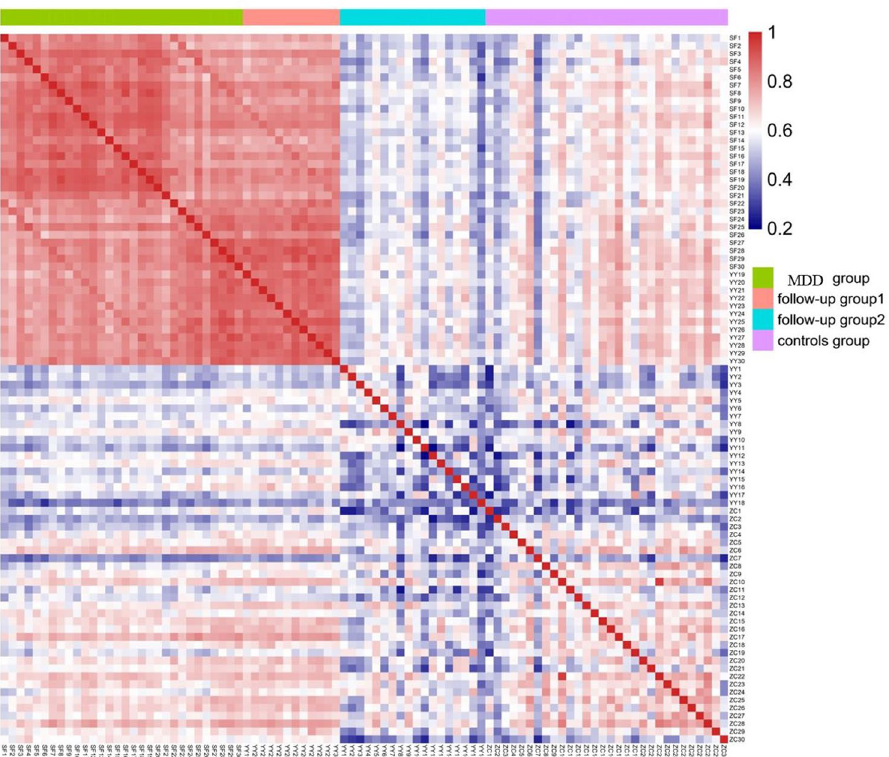
Figure 4. Spearman correlation coefficient heat map between samples. The closer the calculated Spearman correlation coefficient is to 1, the redder the color in the heat map, indicating the stronger correlation between the two samples. Follow-up group 1 had high correlation with Controls group. Follow-up group 2 had high correlation with MDD group.